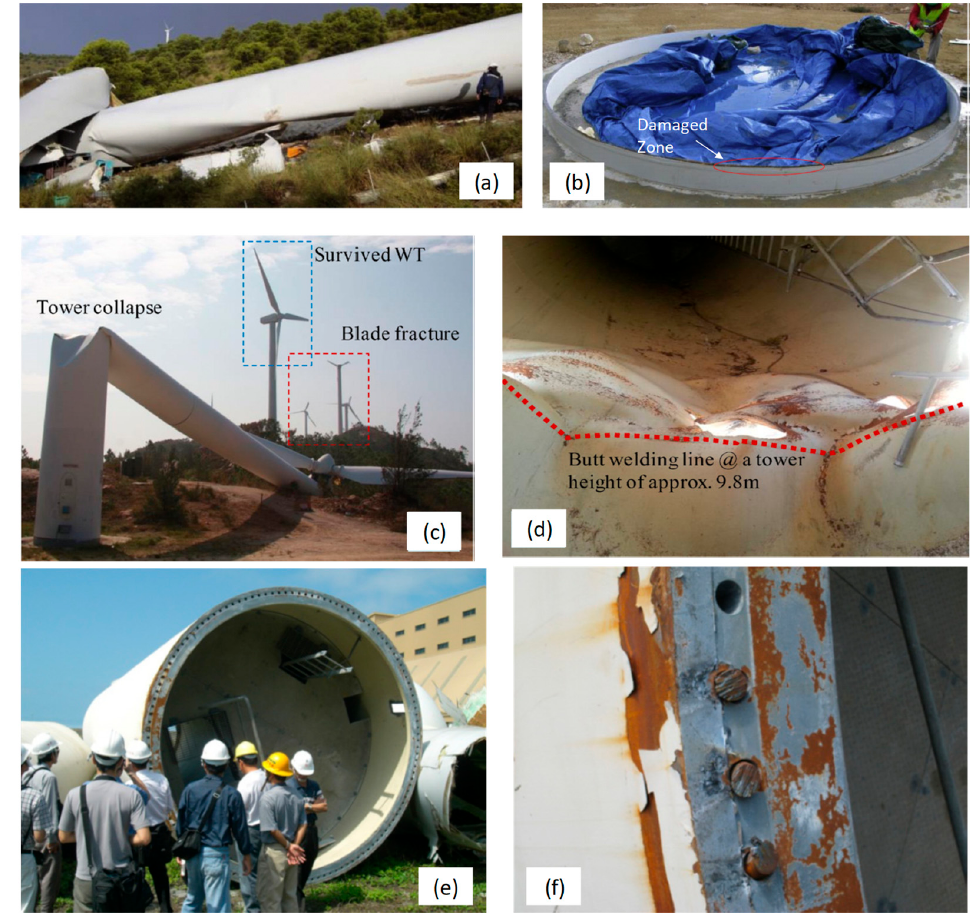
Figure 4. ( a ) The scene of the wind turbine tower collapsed at the wind farm Abuela de Santa Ana, Spain caused by joint failure. ( b ) The view of the damaged joint where the failure began. ( c ) The structural failure of a wind turbine tower in China’s Shanwei city caused by super typhoon Usagi. ( d ) The view of local buckling of the tower at wall-thickness transition zone. ( e ) The view of the fractured tubular tower section of a wind turbine in Taiwan. ( f ) The scene of fractured bolts (( a , b ) adapted from [65] , ( c , d ) adapted from [67] , and ( e , f ) adapted from [4] ).